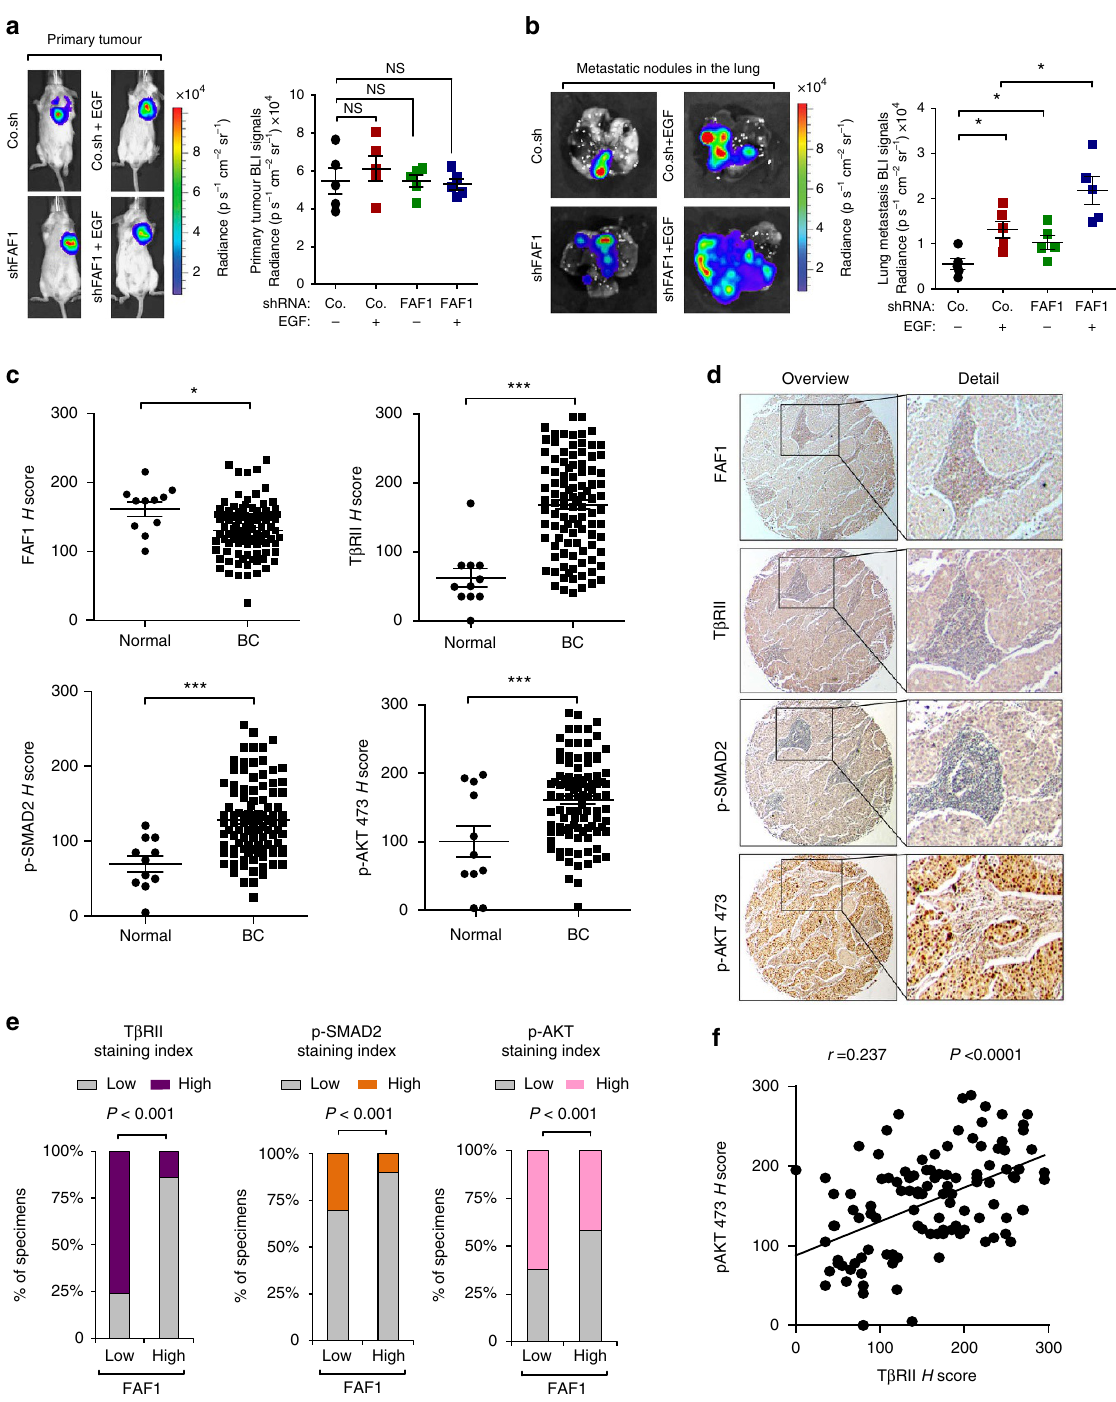
Figure 8 | Loss of FAF1 correlates with increased T b RII as well as downstream p-SMAD2 and p-AKTexpression in patients. ( a ) Bioluminescent imaging (BLI) of representative mice from each group at week 3 following injection with empty vector (PLKO.1) or 4T1 breast cancer cells stably depleted of FAF1 and pre-treated with or without EGF (5ngml (cid:2) 1 ) for 8h. Ventral images of the mice are shown (left panel). The BLI signal from primary tumours obtained from every mouse in each experimental group is shown. NS, not significant (right panel). ( b ) BLI of representative metastatic nodules in the lung from each experimental group is shown (left panel). Lung metastasis BLI signal for every mouse in each experimental group was analysed and is shown in the right panel (right panel). Data are presented as the mean ± s.d. ( c – f ) Immunohistochemistry analysis of FAF1, T b RII, p-SMAD2 and P-AKT 473 in breast cancer tissue microarrays; expression of FAF1 and T b RII, P-SMAD2 and P-AKT 473 in normal ( n ¼ 11) and breast cancer ( n ¼ 110) tissues. The data are the mean ± s.e.m. P values obtained using Student’s t -tests are indicated ( c ). Representative images of each antibody staining are shown. Left panel: objective, (cid:3) 5; right panel: objective, (cid:3) 25 ( d ). Percentage of specimens displaying low or high FAF1 expression compared with the expression levels of T b RII, P-SMAD2 and P-AKT ( e ). Scatterplot showing the positive correlation between T b RII and P-AKT 473 expression in patients. Pearson’s coefficient tests were performed to assess significance ( f